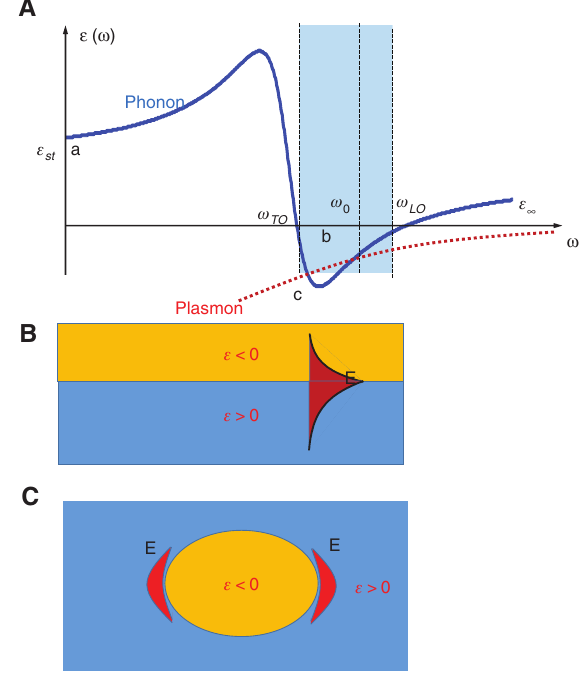
Figure 1: Origin of surface phonon polaritons (SPhPs). (A) Dispersion of phonons and plasmons. The regions A, B, and C correspond to three different ways to achieve a resonant mode: dielectric resonator, SphP, and SPP, respectively. (B) Propagating SPhP. (C) Localized